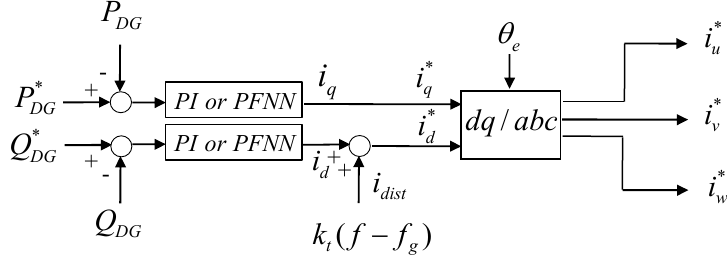
Figure 3. Control block of proposed active islanding detection method.